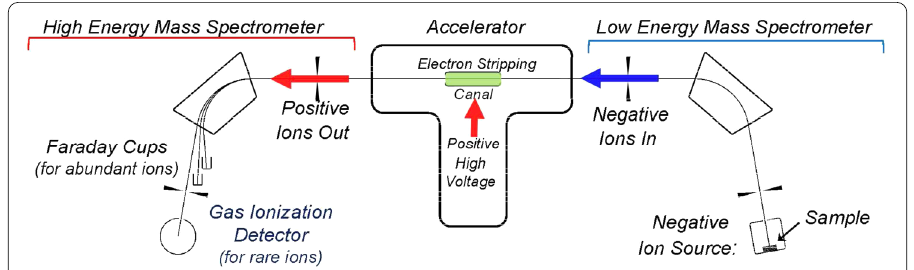
Figure 1 Basic parts of an AMS system using a tandem